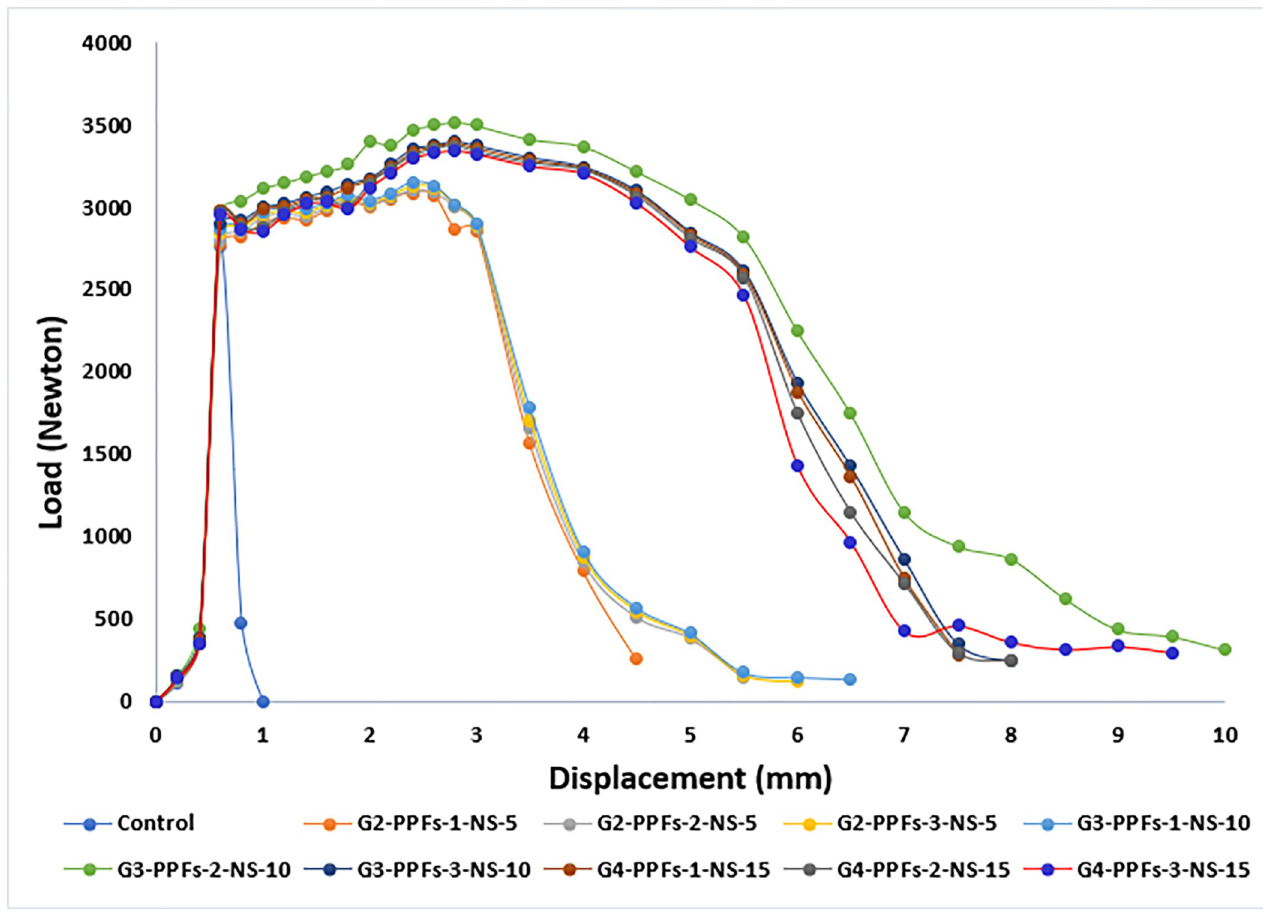
Fig 16. Load displacement curve for all